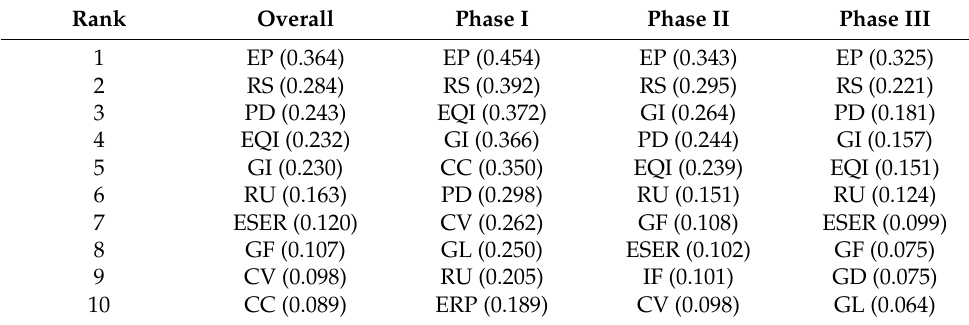
Table 2. Normal degree centrality of policy goals.